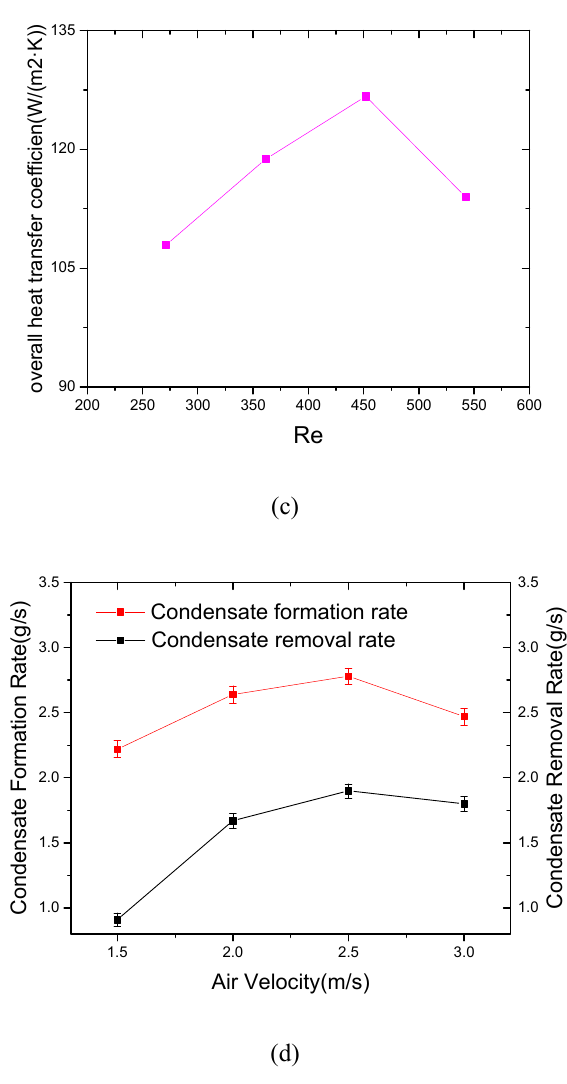
Figure 8. Variation in heat transfer characteristics under different air velocities: ( a ) air outlet temperature, ( b ) the air-side heat transfer and overall heat transfer coefficient, ( c ) Re and overall heat transfer coefficient and ( d ) condensate rate.